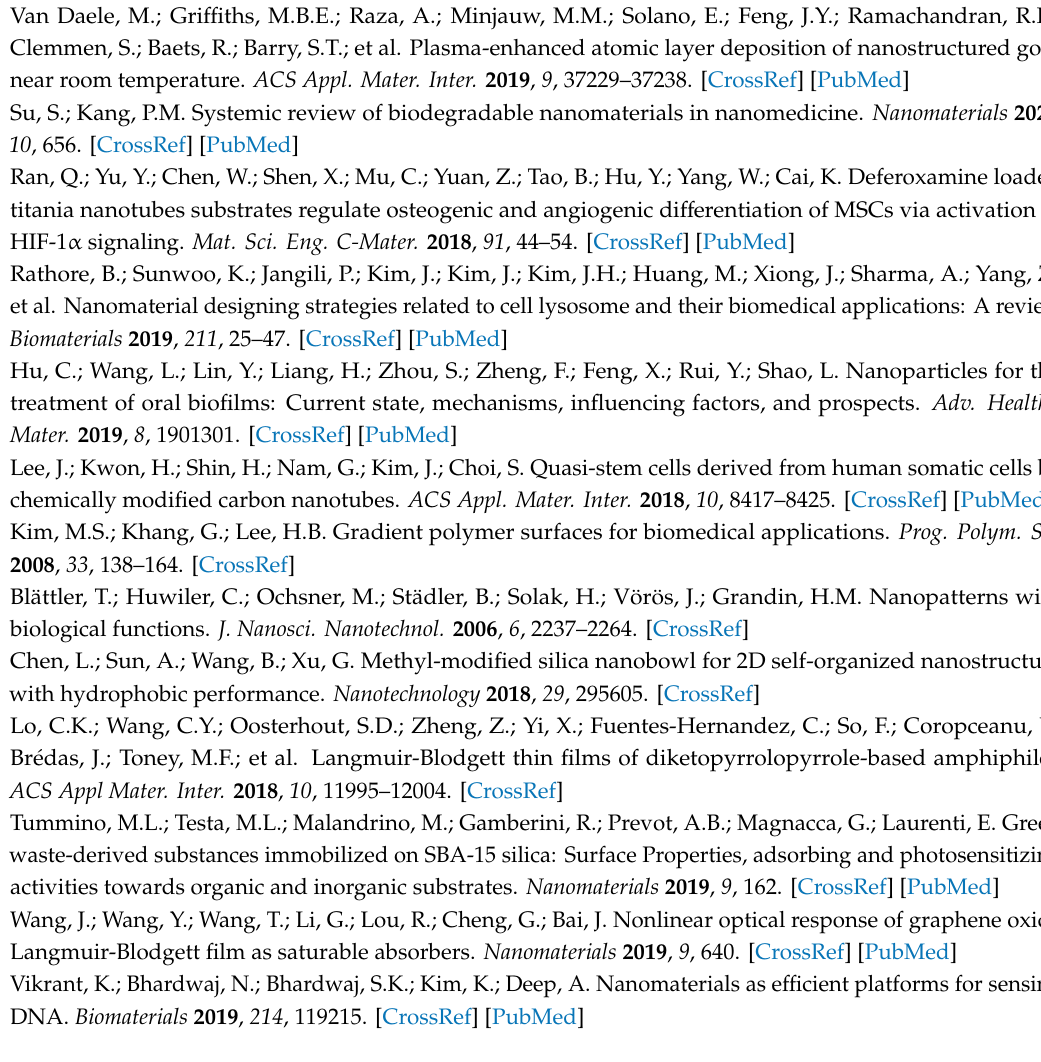
Figure S1: AFM images of (a) SN-60, (b) SN-150, (c) SN-300, (d) SN-500, and (e) SN-700. Scale indicated (a) 1 µ m and (b-e) 3 µ m. Figure S2: Actin-focal adhesion immunostaining in rMDSCs grown on SN at 9 d. (a) SN-60, (b) SN-150, (c) SN-300, (d) SN-500, (e) SN-700, and (f) glass. DAPI (blue), actin (red); FAC (vinculin; green). Magnification, x400; scale bar = 50 µ m. (d’9), (e’9), and (f’9) are enlarged images (magnification, × 1000). Figure S3: Actin-focal adhesion immunostaining in rMDSCs grown on SN for 1, 5, and 9 d. (d) SN-500, (e) SN-700, and (f) glass. The numbers indicate 1, 5, and 9 d. DAPI (blue), actin (red); FAC (vinculin; green). Magnification, x400; scale bar = 50 µ m. Figure S4: Actin-integrin β 1 immunostaining in rMDSCs grown on SN at 9 d. (a) SN-60, (b) SN-150, (c) SN-300, (d) SN-500, (e) SN-700, and (f) glass. Blue, DAPI; red, actin; green, integrin β 1. Magnification, × 400; scale bar = 50 µ m. (d’9), (e’9), and (f’9) are enlarged images (magnification, × 1000). Figure S5: Actin-integrin β 1 immunostaining in rMDSCs grown on SN for 1, 5, and 9 d. (d) SN-500, (e) SN-700, and (f) glass. The numbers indicate 1, 5, and 9 d. Blue, DAPI; red, actin; green, integrin β 1. Magnification, × 400; scale bar = 50 µ